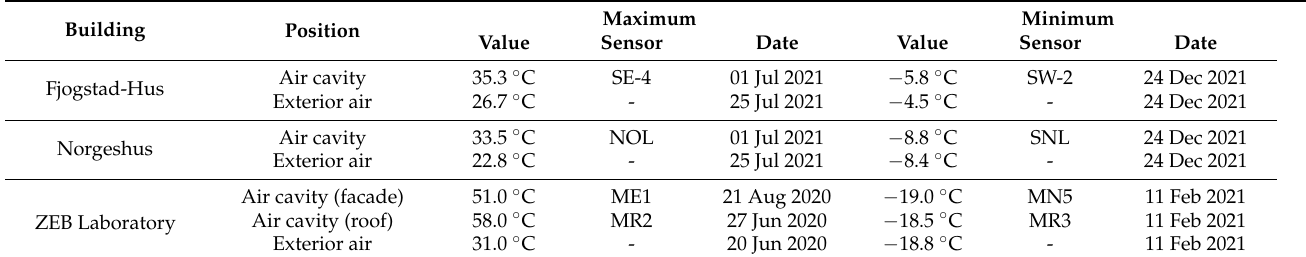
Figure 10. The measured wood moisture content in the air cavities of the three case buildings. Table 3. The maximum and minimum temperatures measured in the air cavity of each building, and the highest and lowest recorded exterior air temperatures.